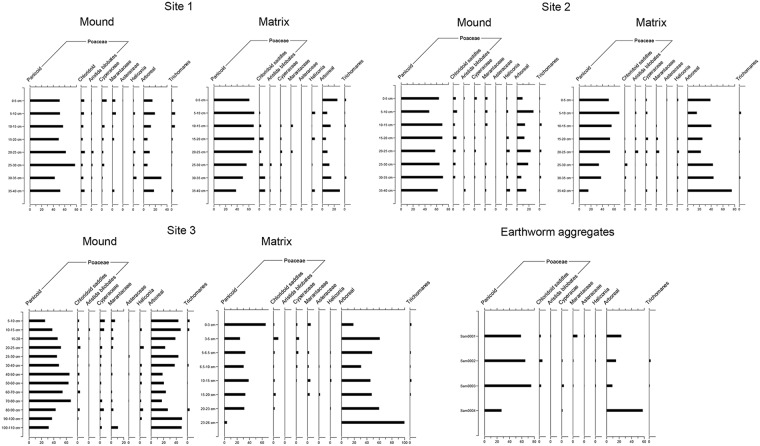
Summary diagram of phytolith morphotype composition in soils of Sites 1–3 and in earthworm casts.Horizontal bars represent percentages of phytolith morphotypes for each soil layer.